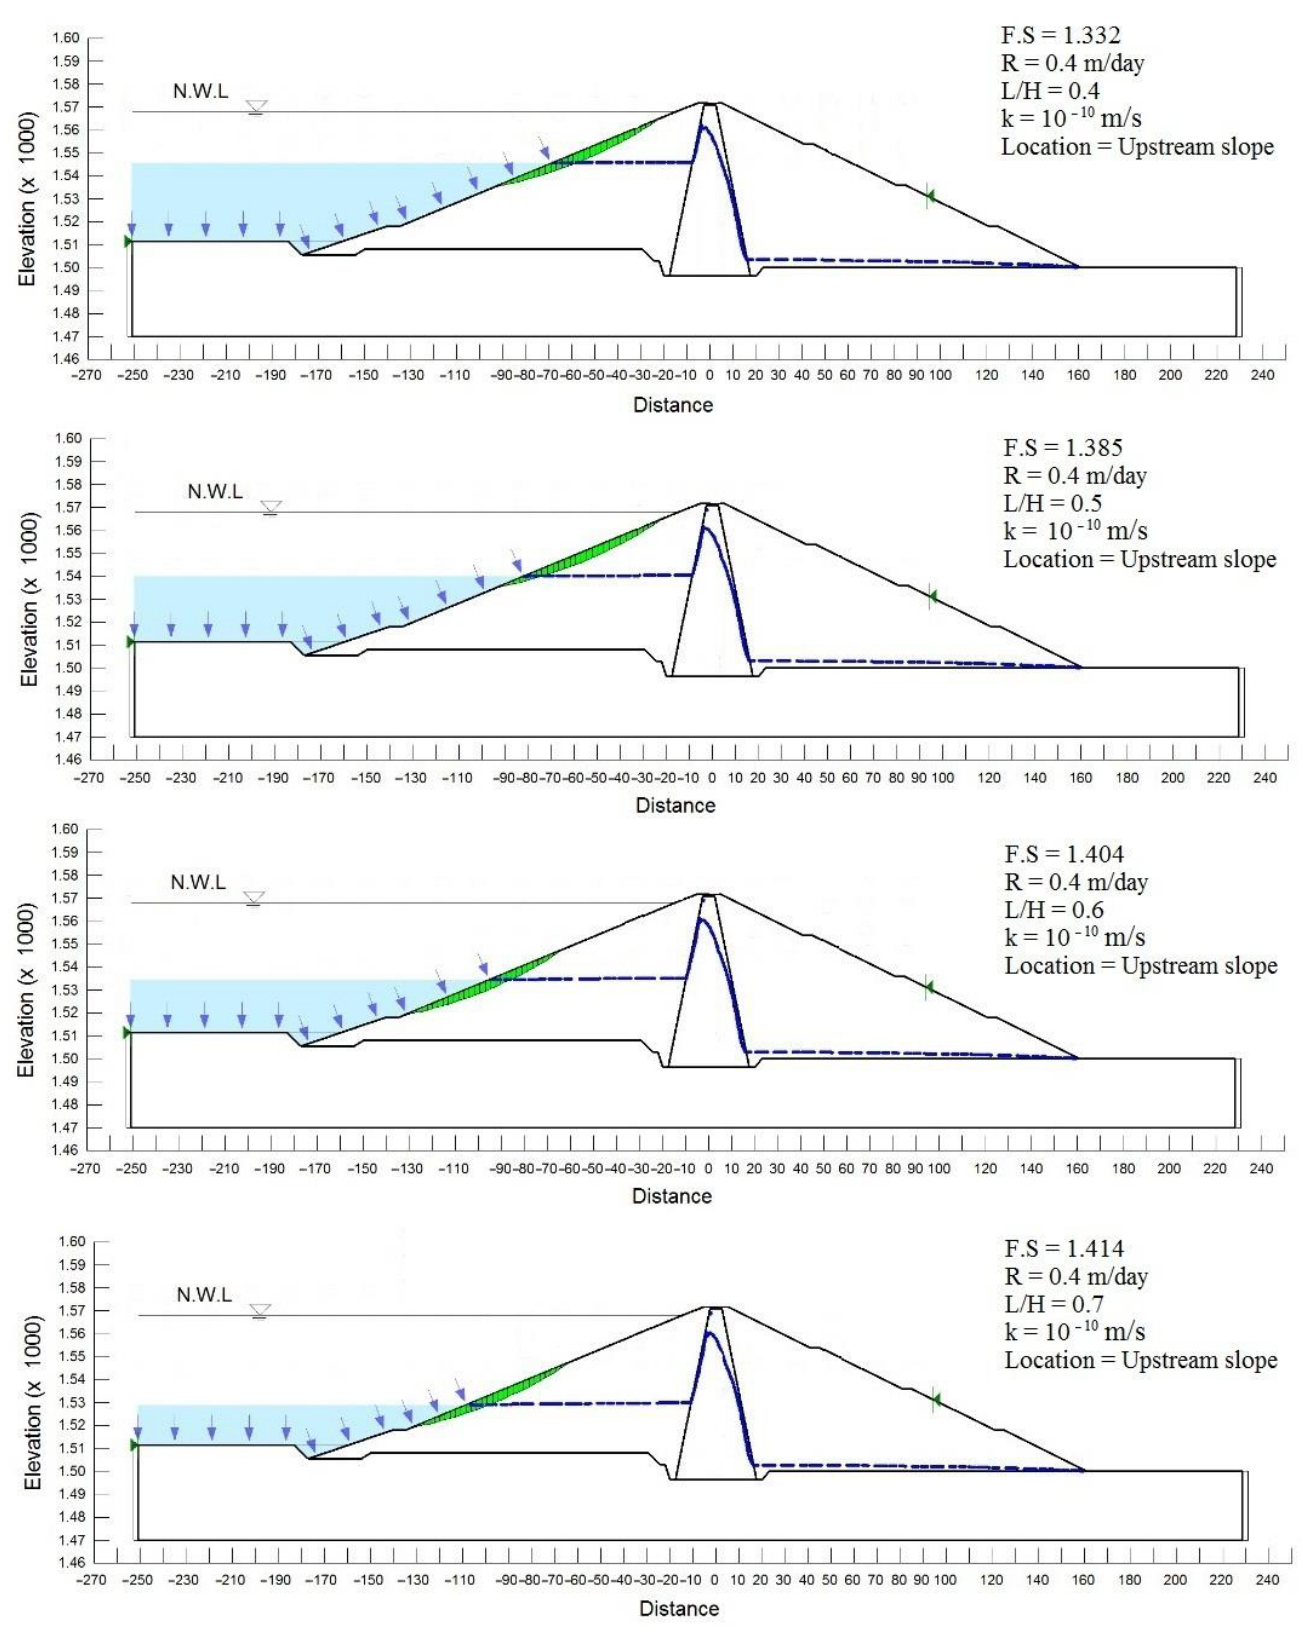
Figure 3. A simple view of the comprehensive modeling for rapid drawdown conditions.